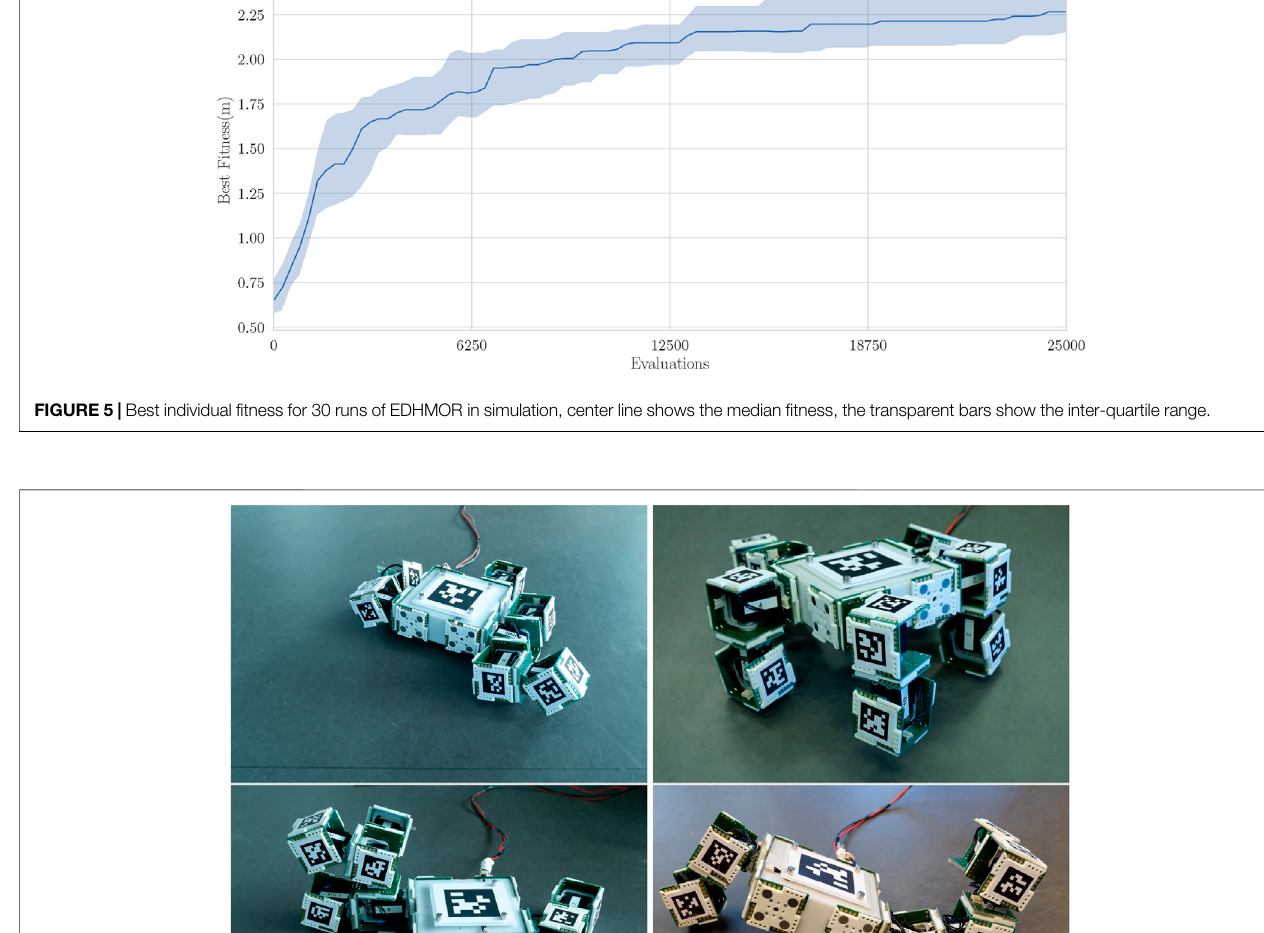
Frontiers in Robotics and AI |